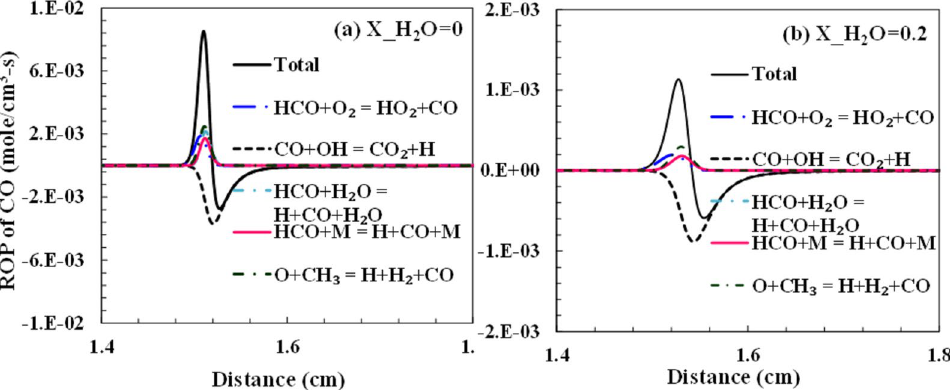
Figure 14. Net rate of production of CO with ( a ) 0% and ( b ) 20% steam dilution using Aramco mechanism.